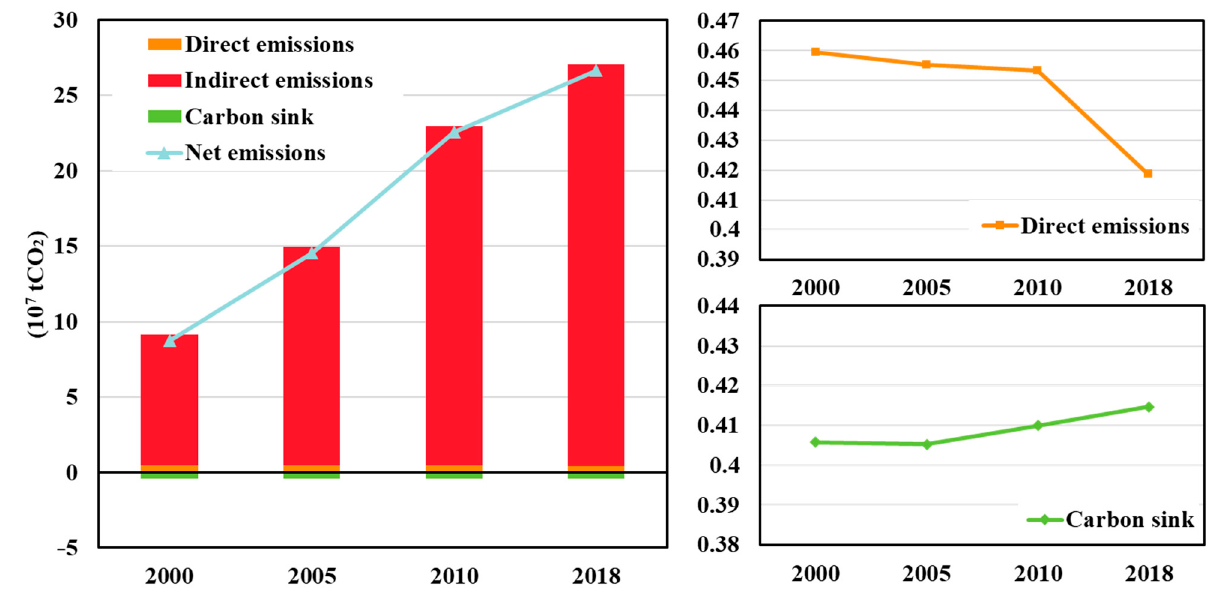
Figure 5. Variations in CO 2 emissions in Beijing–Tianjin–Hebei from 2000 to 2018.